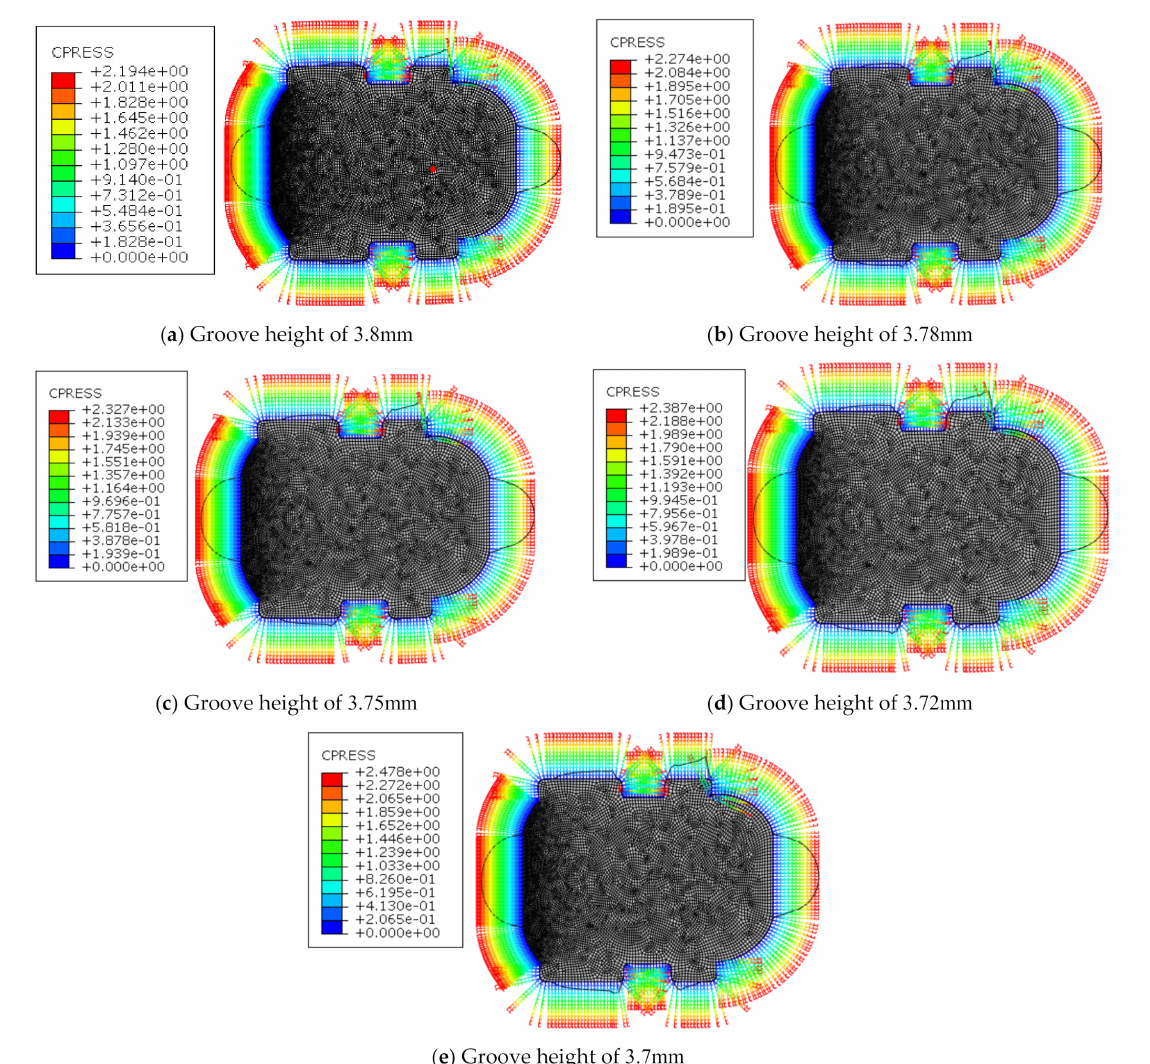
Figure 12. The contact pressure under different dimensions of the